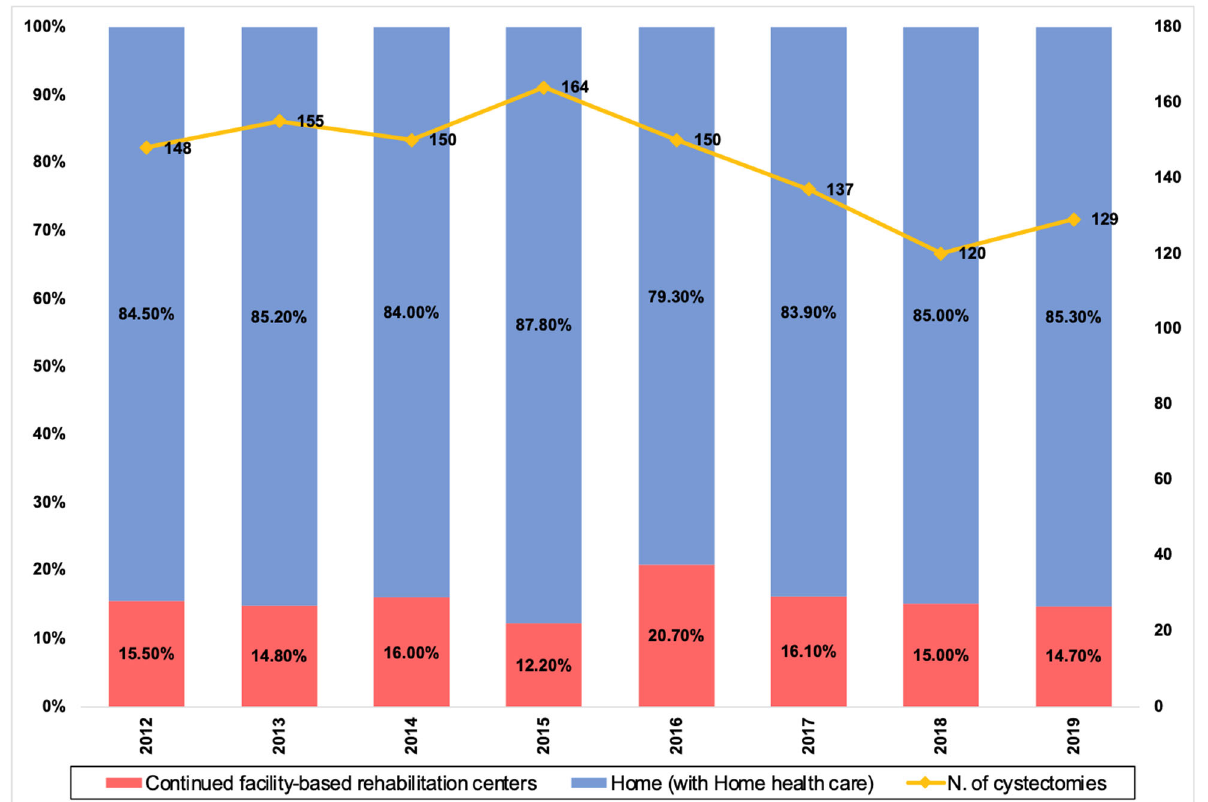
Figure 1. Trend over time of RC performed in our institution (2012–2019) after the implementation of our ERAS protocol and percentage of patients discharged home and to CFRs.